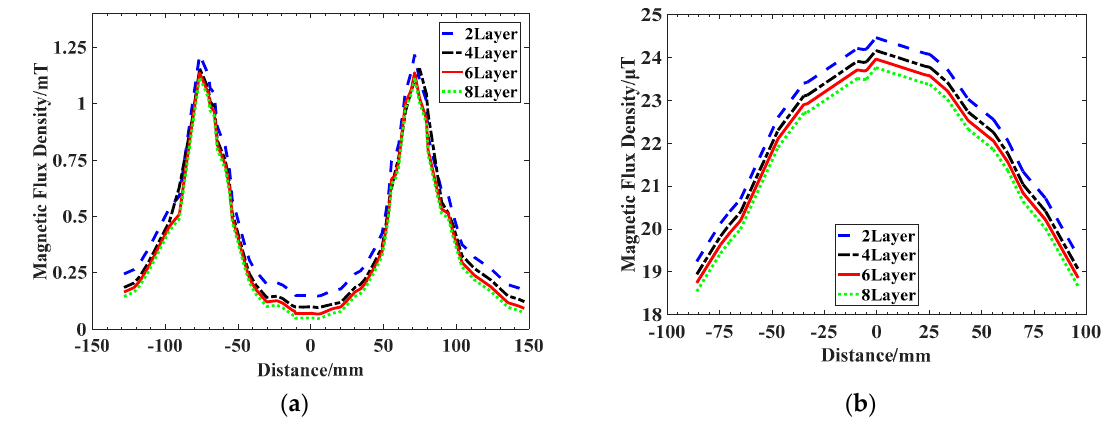
Figure 10. Magnetic flux density versus simulated measurement position. ( a ) Radial 10 mm above receiving coil. ( b ) Axial 250 mm outside the magnetic coupler.